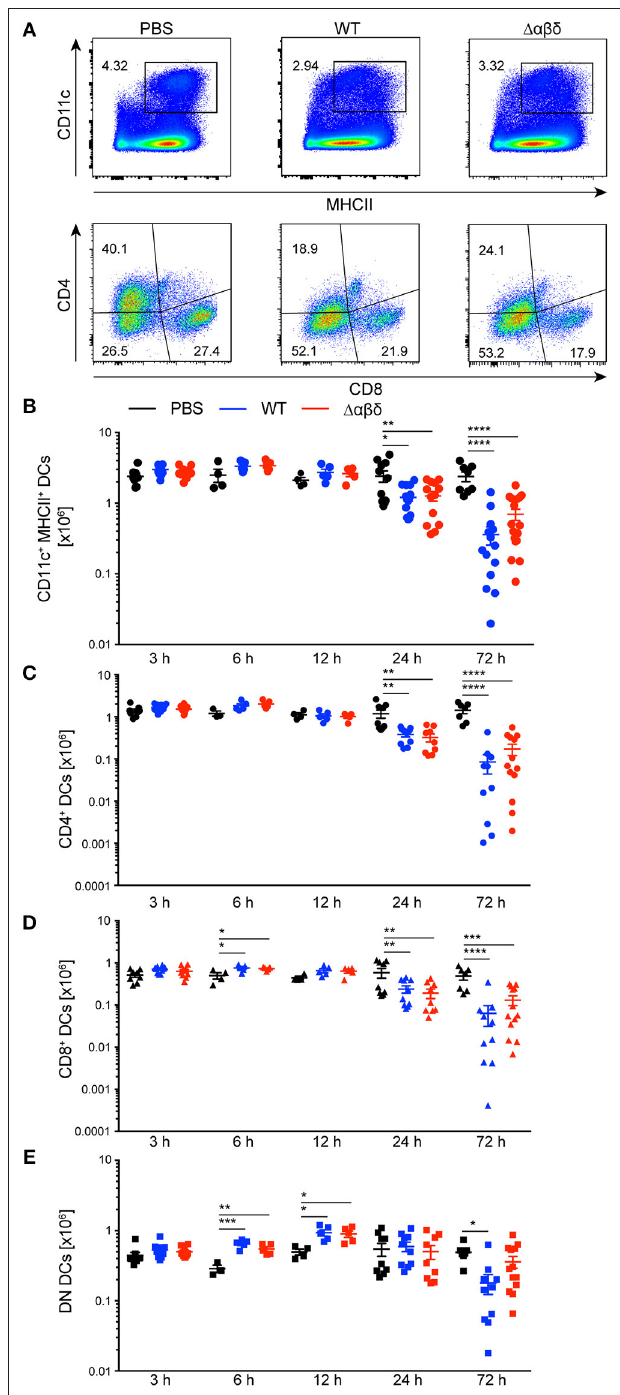
FIGURE 1 | Reduced numbers of splenic DC subsets upon S. aureus infection. C57BL/6J WT mice were either treated with PBS or infected with S.